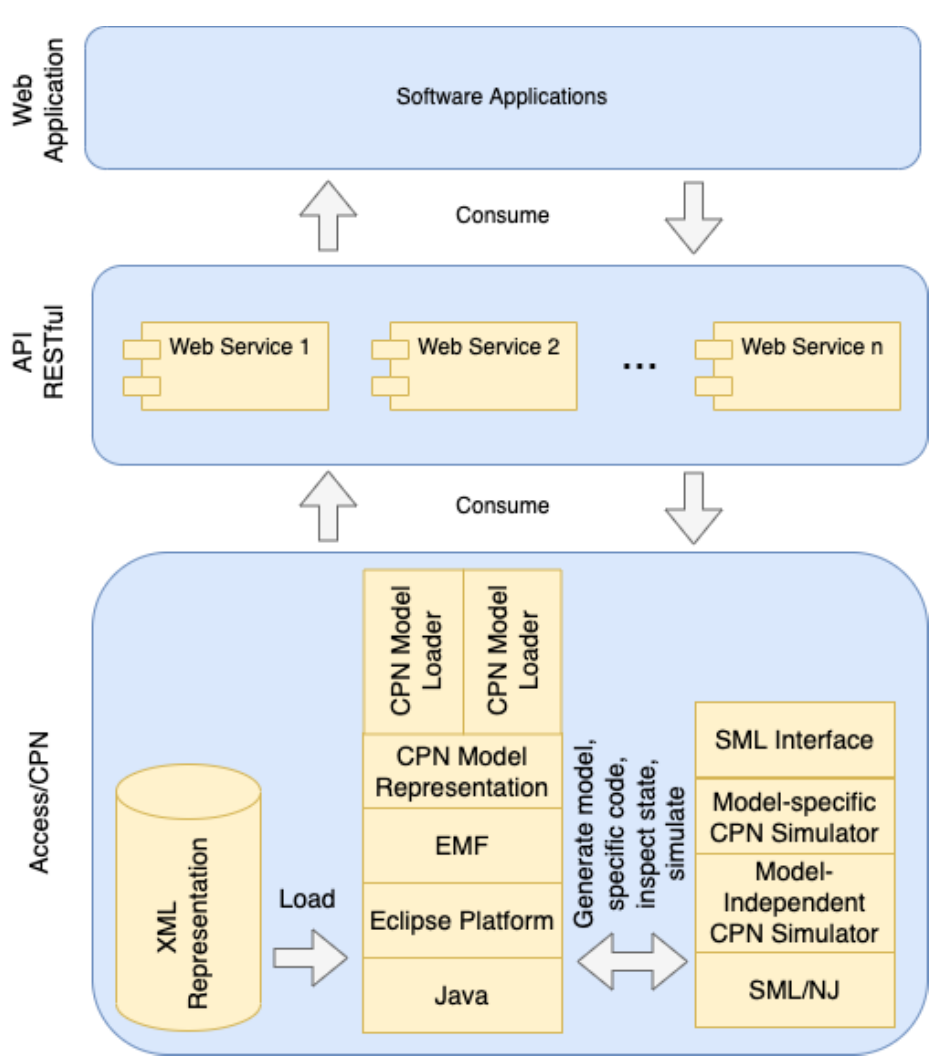
Figure 14. Web application and API implemented as consumers of Access/CPN components